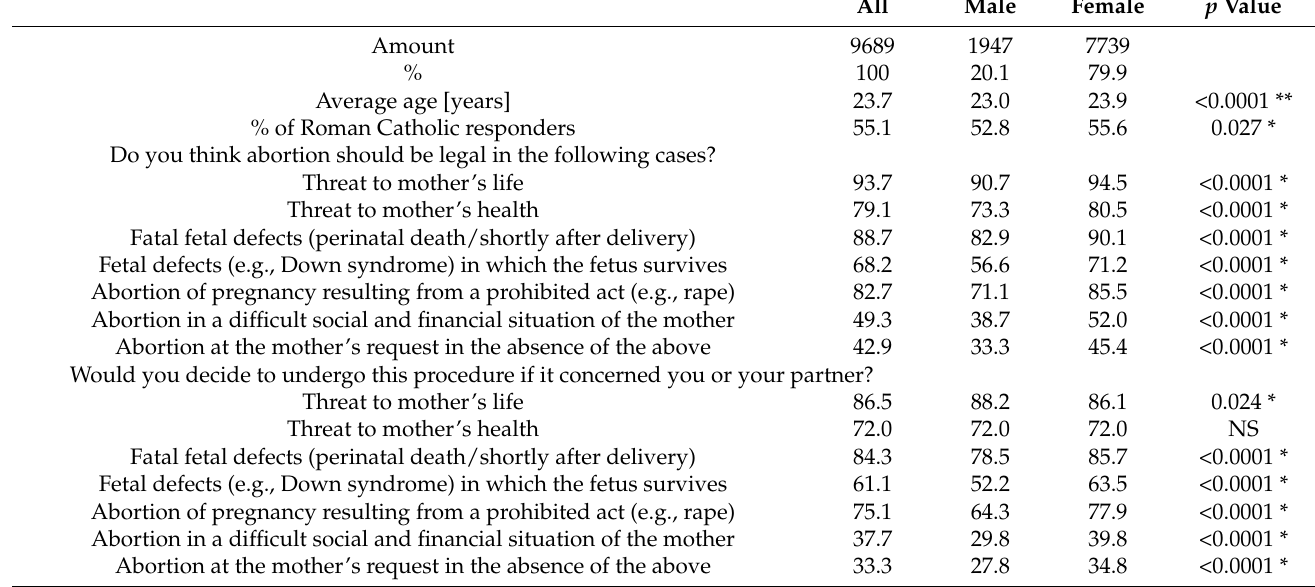
Table 1. Characterization of the study group. All data contained in table are presented as percentage [%] of answers YES for each question (except for row “Average age”, which is measured in years). All